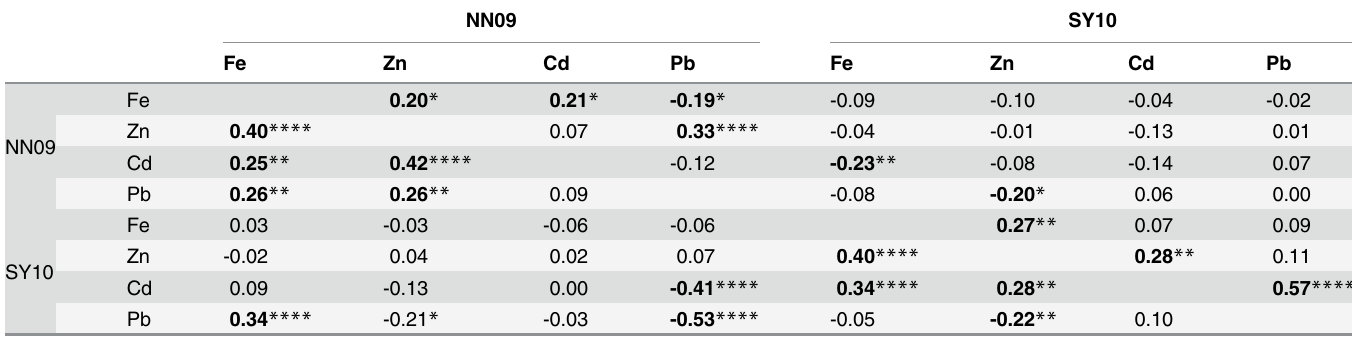
Table 3. Correlation coefficients between grain mineral concentrations in backcross inbred lines with two genetic backgrounds, Ce258 (below the diagonal) and ZGX (above the diagonal) measured in 2009 in Nanning (NN09) and in 2010 in Sanya